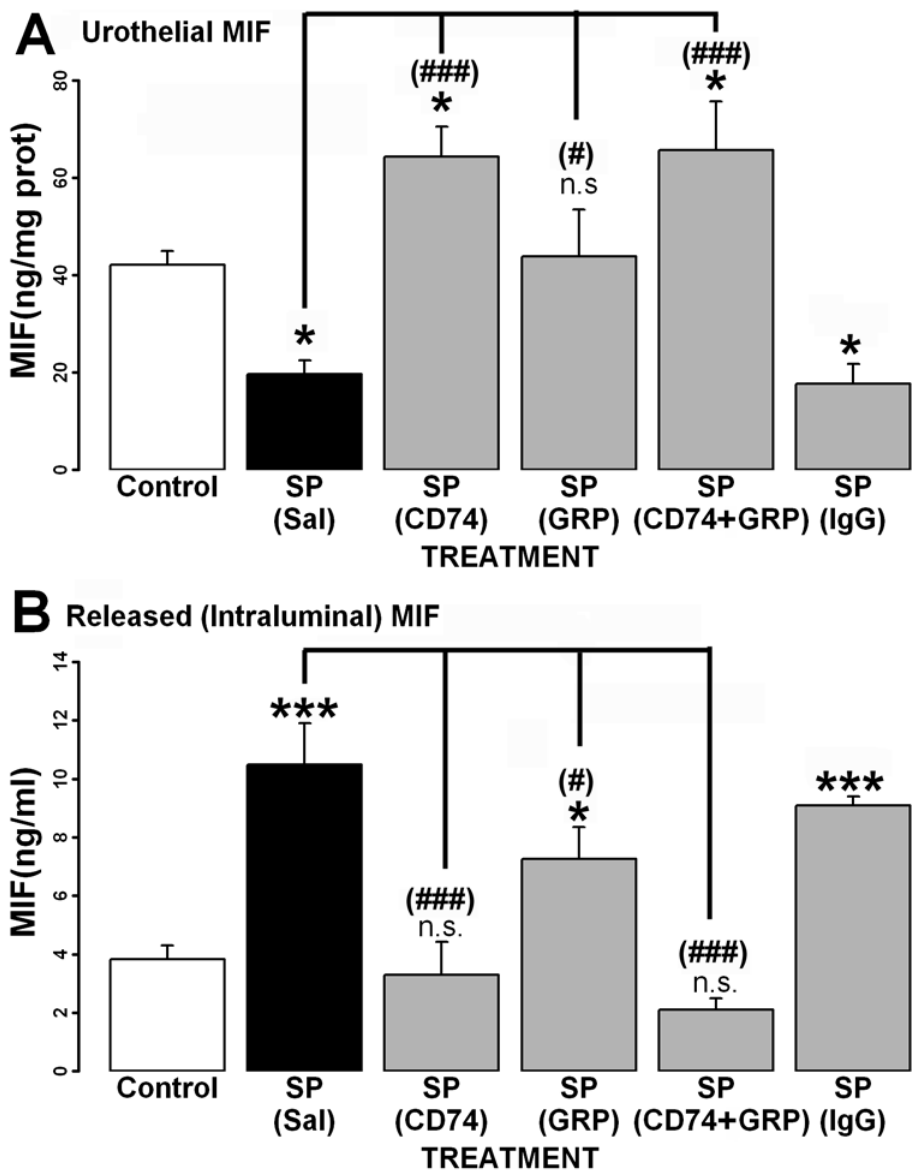
Figure 3. Effect of different intraluminal treatments on substance P (SP)-induced urothelial MIF release. Intraluminal treatment for each group is in parenthesis. A) Urothelial MIF is decreased after SP treatment, suggesting MIF release from the urothelium. This effect is prevented by intraluminal treatment with CD74 ab (CD74), GRP78 ab (GRP) or a combination of both. Intraluminal treatment with non-specific IgG did not prevent the decrease in urothelial MIF produced by SP. B) SP treatment significantly increased MIF in intraluminal fluid. Intraluminal treatment with CD74 ab prevented this increase, whereas treatment with GRP-78 ab (GRP) decreased the amount of MIF in the intraluminal fluid (compared to SP only), but it was still increased (compared to saline). Treatment with both CD74 ab and GRP78 ab (CD74 + GRP) also prevented SP-induced MIF release. Intraluminal non-specific IgG had no effect. *=comparison to saline p , 0.05; ***=p , 0.001; ( # )=comparison to SP(Sal) p , 0.05;( ### )=p , 0.001; n.s.=not